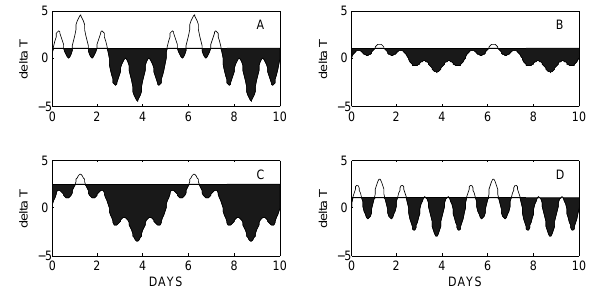
Fig. 6. Principles of NLC modulation by planetary-waves and tides. Panel (A) shows that case when the mean situation (tem- perature/water vapour) is slightly below the saturation level, and temperature perturbations from a combination of tides (1-day) and planetary waves (5-day) produce alternating conditions of satura- tion (black) and non-saturation (white). In panel (B) , the wave per- turbations are smaller, and in panel (C) the mean temperature is further below the saturation level. In panel (D) , the amplitude of the planetary wave is decreased, but the tidal amplitude is the same as in (A).